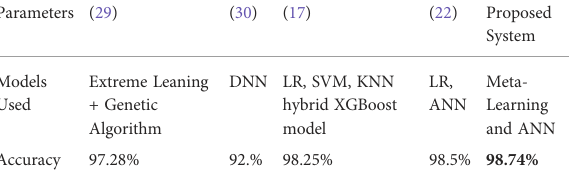
TABLE 5 Comparison with other classi fi